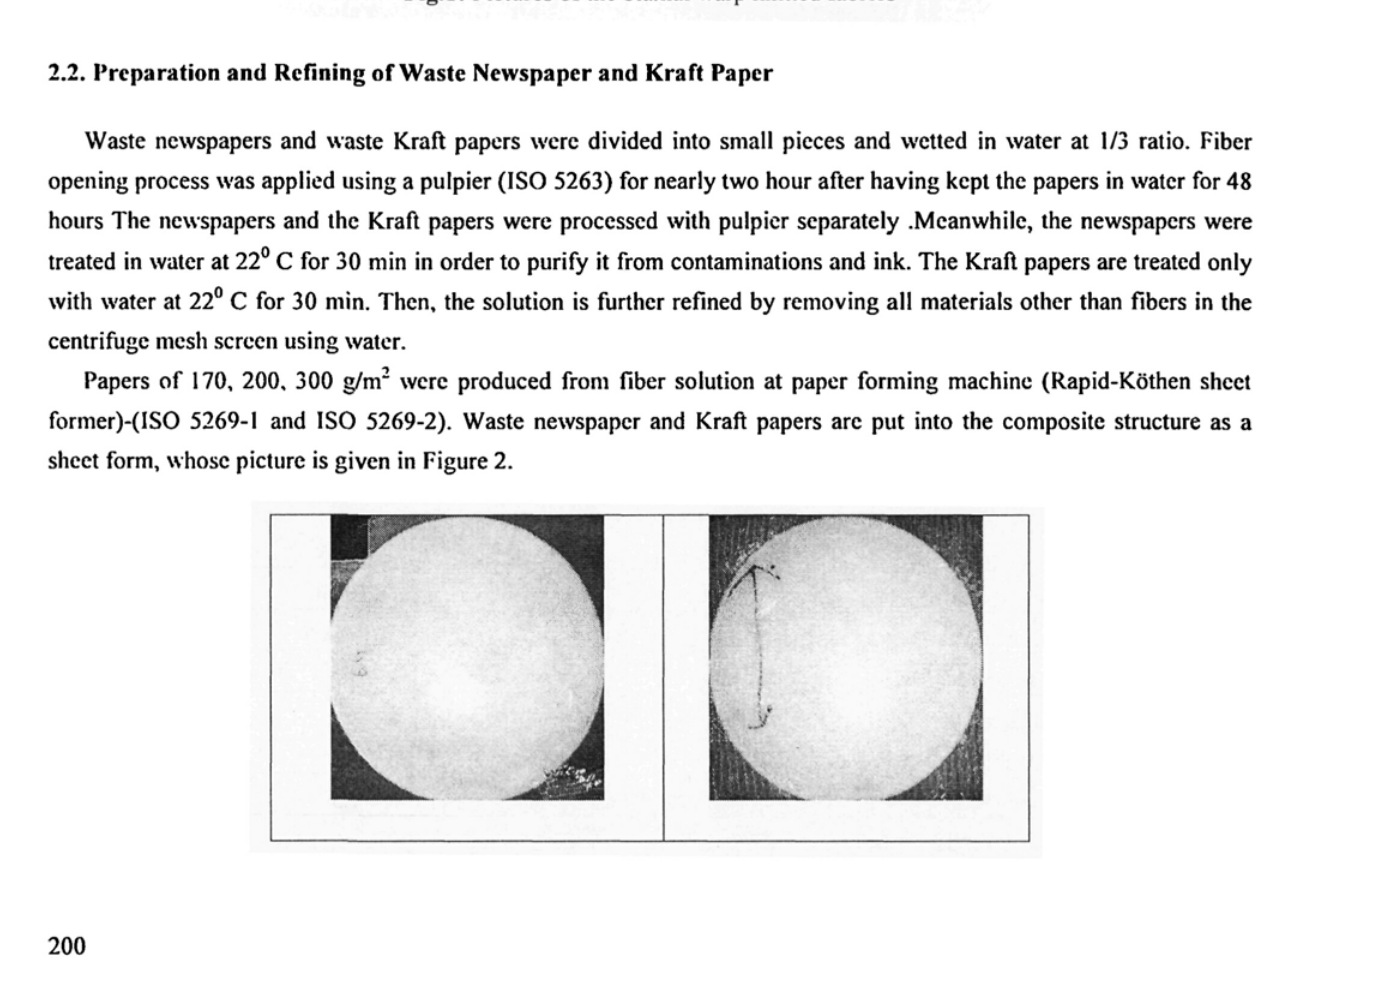
Fig.l: Pictures of the biaxial warp knitted